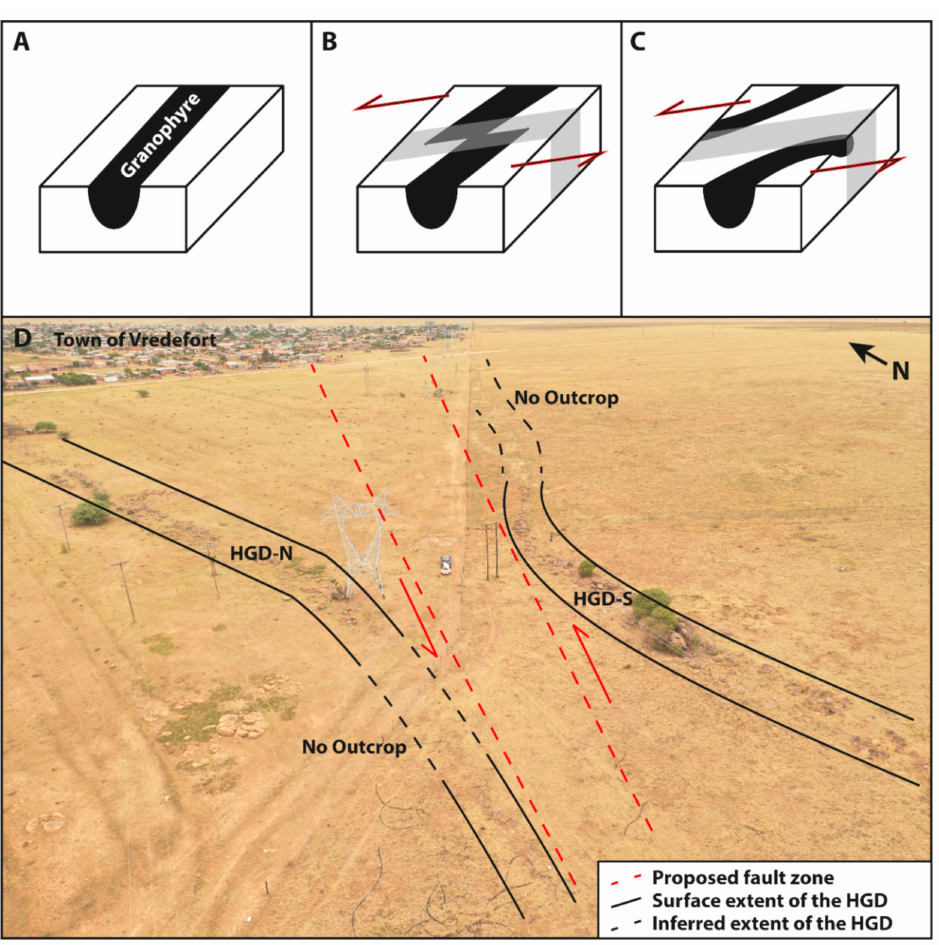
Figure 16. Schematic diagrams and annotated expression of the Holfontein Granophyre Dike with the proposed strike-slip sinistral fault zone. Schematic diagrams A–C show intact ( A ), intermediate ( B ), and final ( C ) stages of shearing of the HGD. ( D ) Aerial photograph of the HGD showing the proposed orientation of the fault